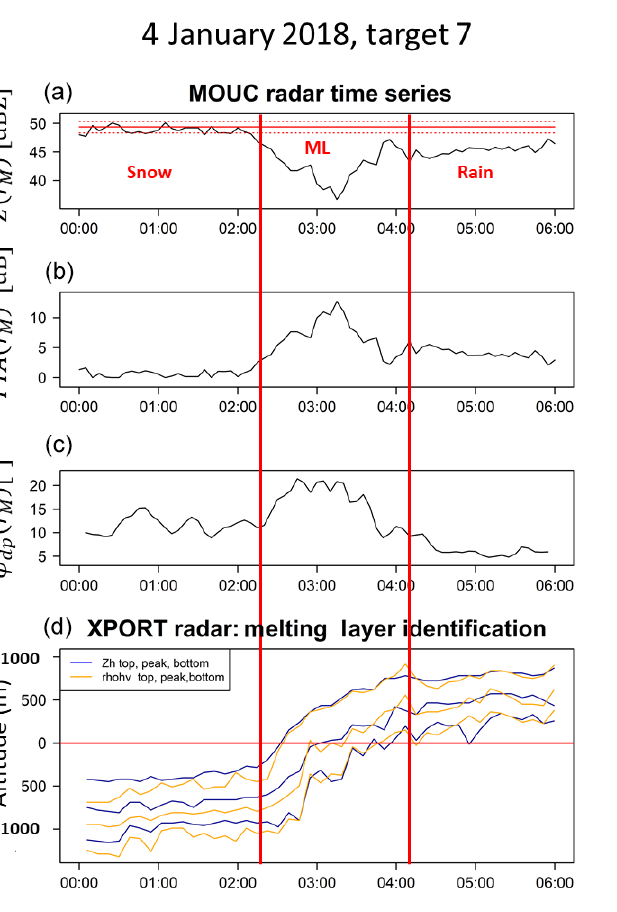
Figure 6. Time series of (a) the apparent reflectivity values of a given mountain reference target together with the dry weather ref- erence (solid red horizontal lines for the mean) and the 10% and 90% quantiles (broken red lines), (b) the resulting PIA estimates (dB), and (c) the corresponding φ dp (r M ) values ( ◦ ) for the 0 ◦ PPI of the MOUC radar during the 3–4 January 2018 stratiform rain event. (d) displays the results of the ML detection algorithm performed with the XPORT 25 ◦ PPI data (see text for